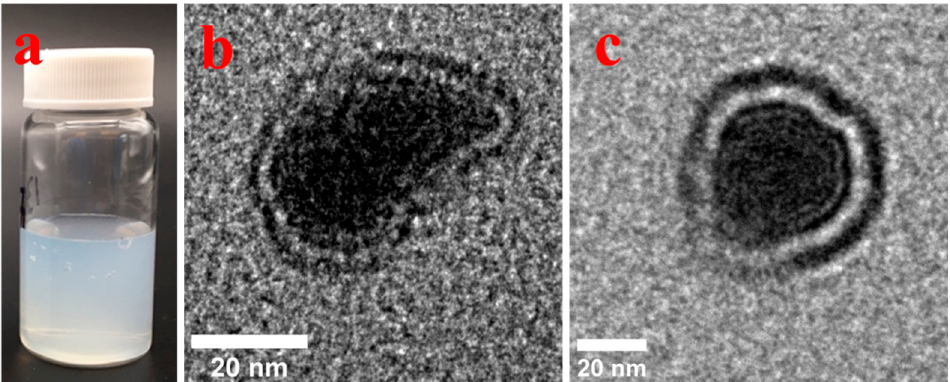
Figure 1. ( a ) NRTOCl dispersed in 1% ( v/v ) ethanol in water; ( b , c ) TEM images of NRTOCl dispersed in 1% ( v/v ) ethanol in water.